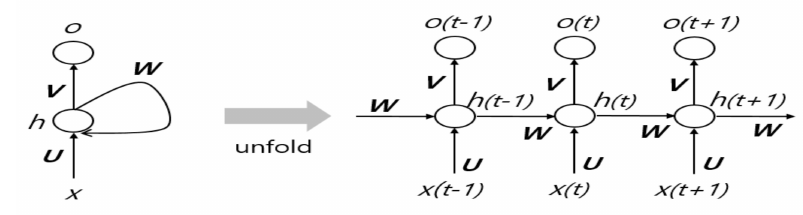
Figure 4. Structure of a recurrent neural